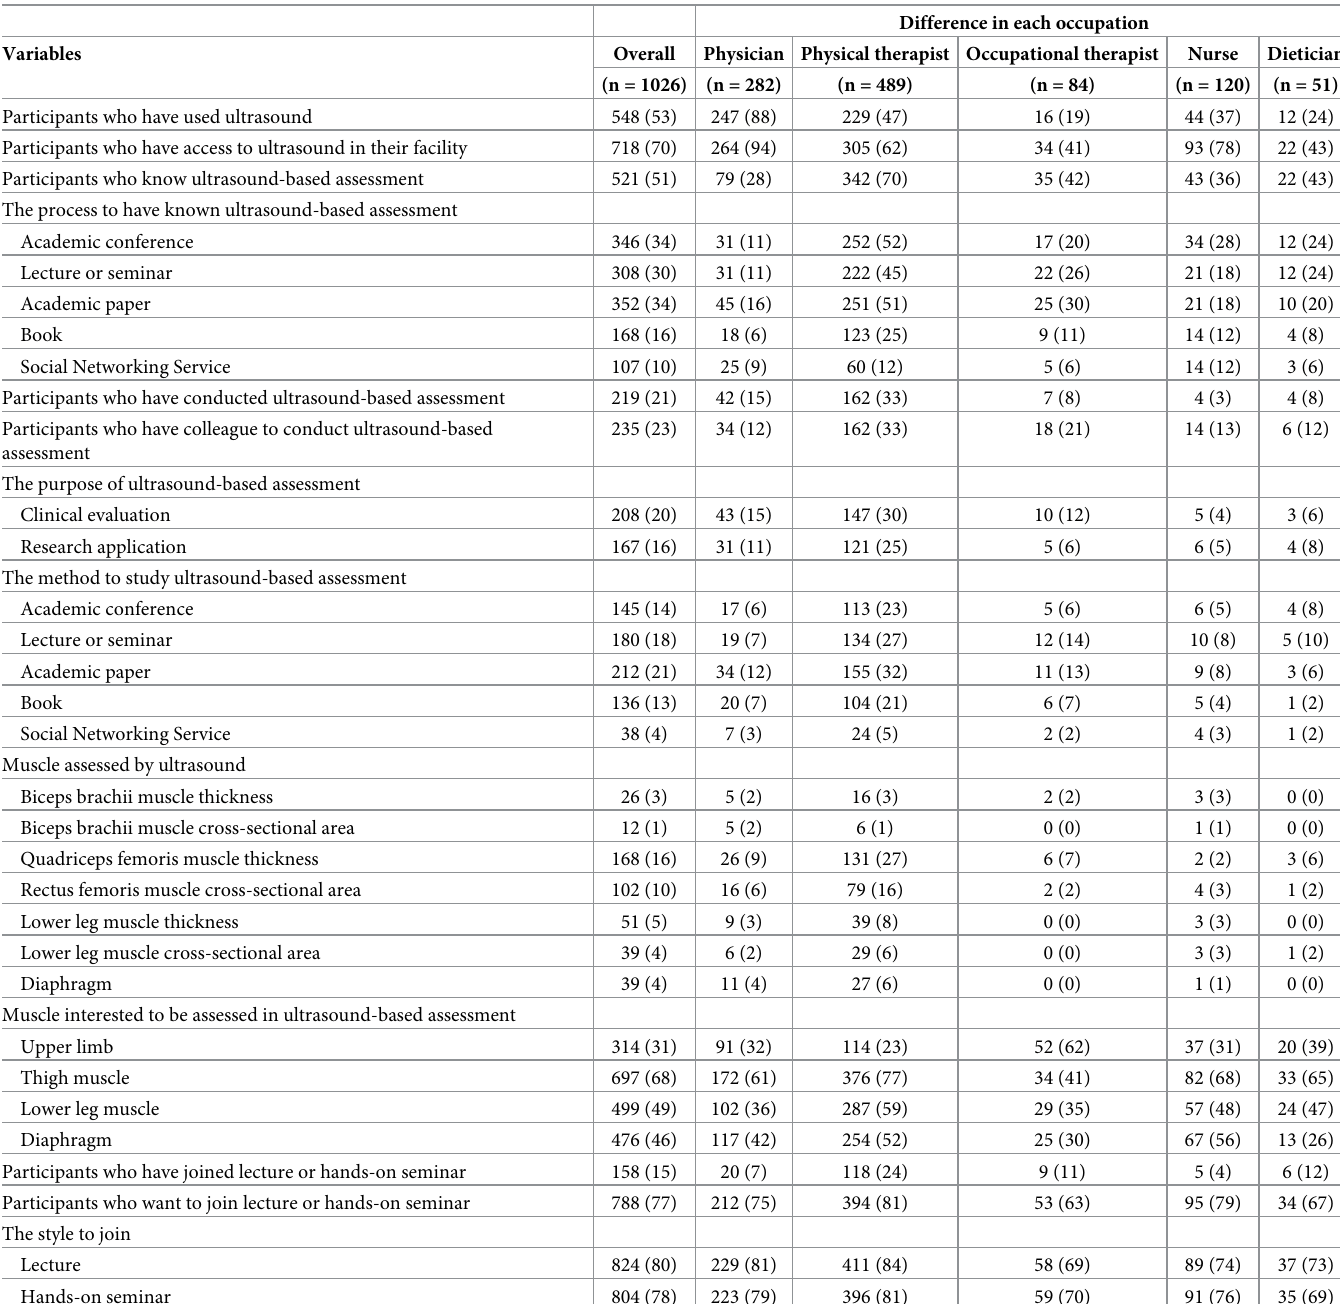
Table 2. Ultrasound-based muscle mass